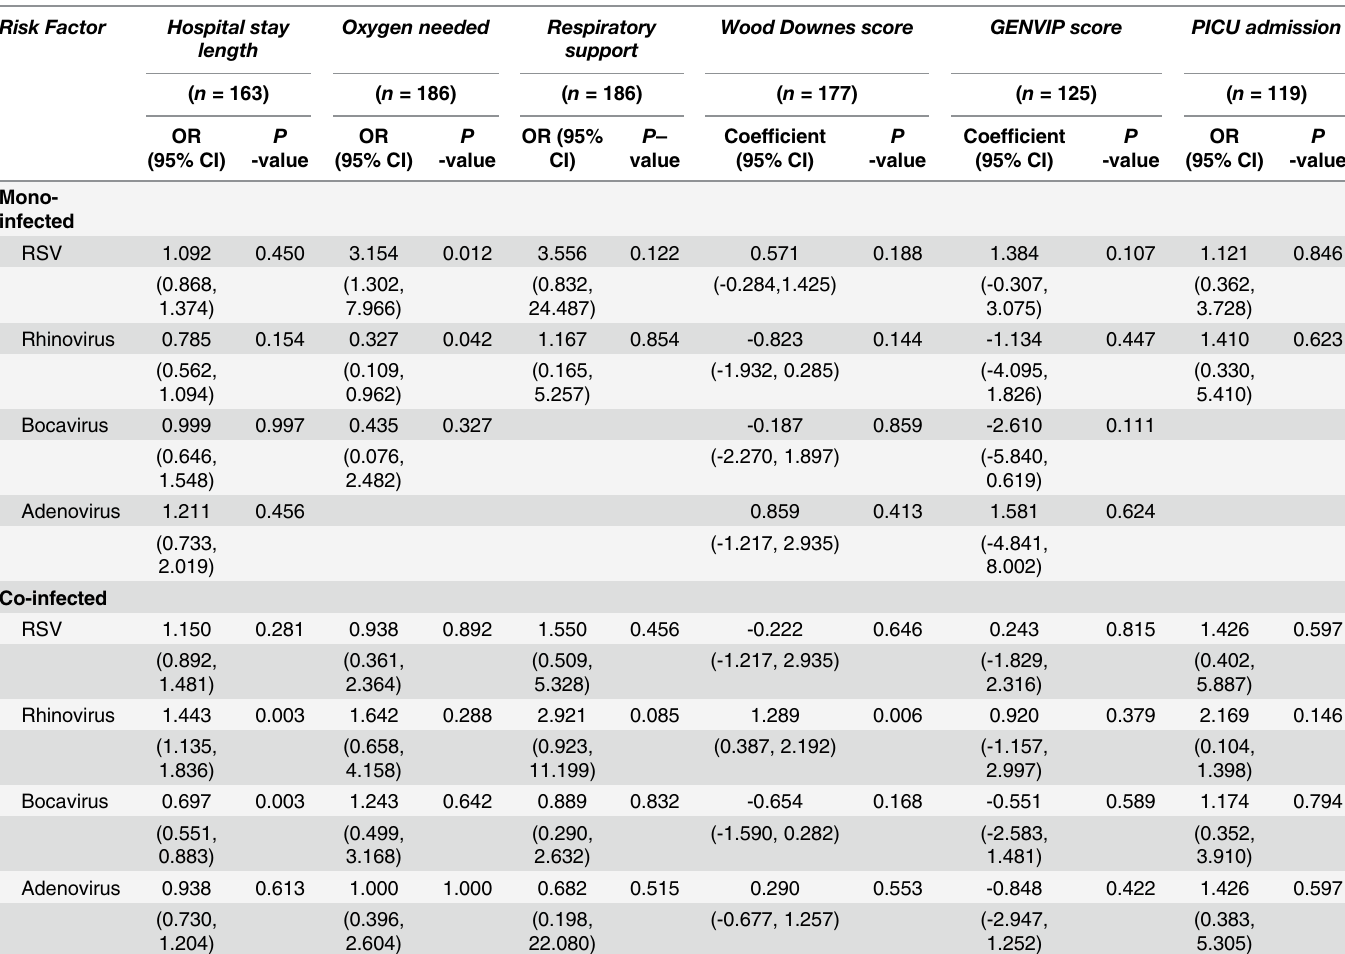
Table 3. Comparison of virus and disease severity of the main cohort considering the virus as single pathogen or as co-infection in the sample. Different statistical models were considered to study the bivariate association between the variables depending on the dependent variable. A binary logistic model was used for the binary variables oxygen needed and respiratory support needed, and a negative binomial regression model for counted data (hospital stay length). Data are presented as OR (confidence interval 95%) and the level of statistical significance was set at